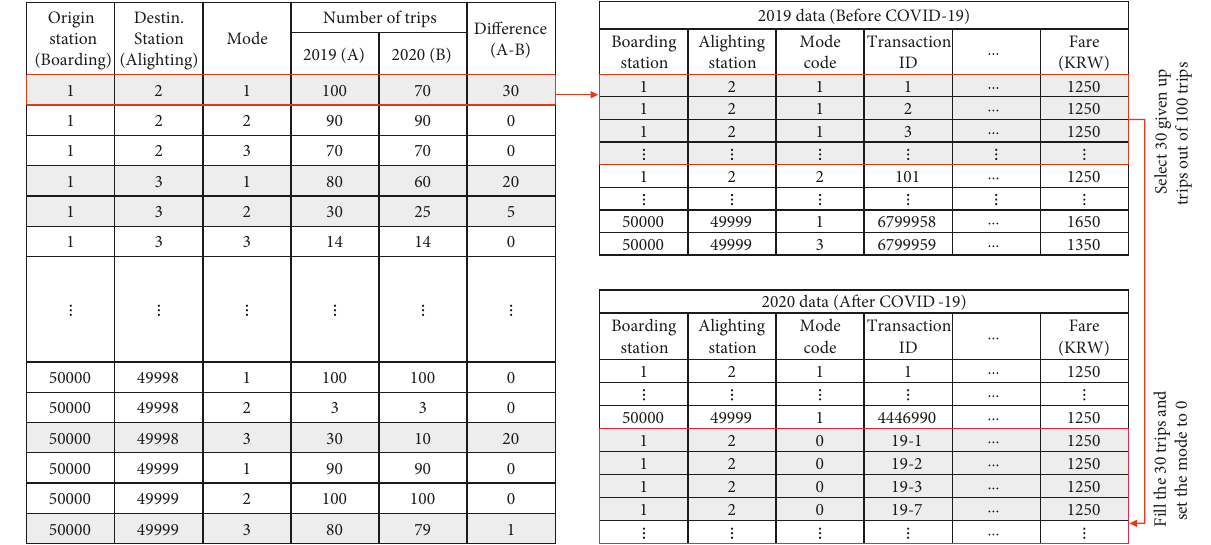
Figure 2: Conceptual illustration of data preprocessing. Table 2: Description and descriptive statistics of the preprocessed